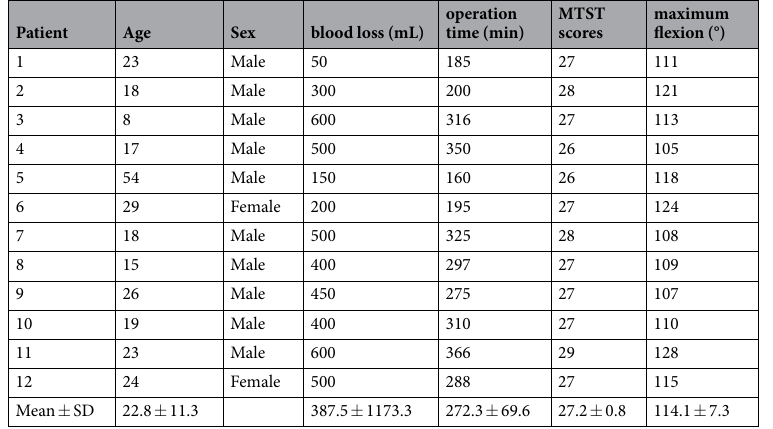
Table 2. The results of implementation parameters. MTST, Musculoskeletal Tumor Society. SD, standard deviation.